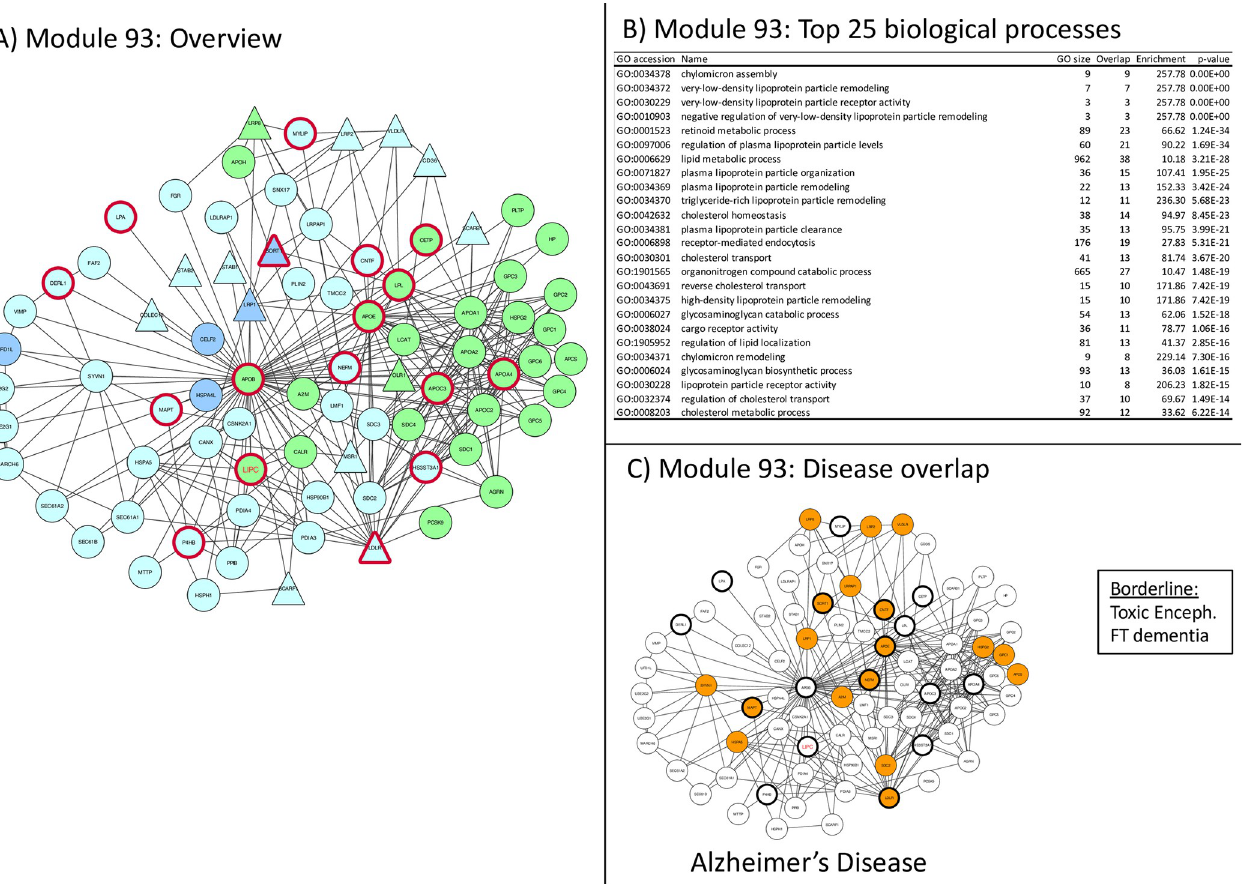
Fig 7. Module 93 –lipid metabolism related. Panel A: thick red border: gene/protein annotated to be ALS-associated on any of the 7 lists. Large red label: gene/protein with GWAS evidence. Triangular shaped nodes: receptors (UniProt keyword). Node colors indicate subcellular location (UniProt keywords): Blue = Nuclear, Green = Secreted, Purple = conflicting nuclear/secreted, cyan = neither nuclear nor secreted (likely cytosolic). Panel B: Gene Ontology overrepresentation analysis. Panel C: Thick border: ALS-associated (as panel A), Colored node: Disease-associated gene/protein.